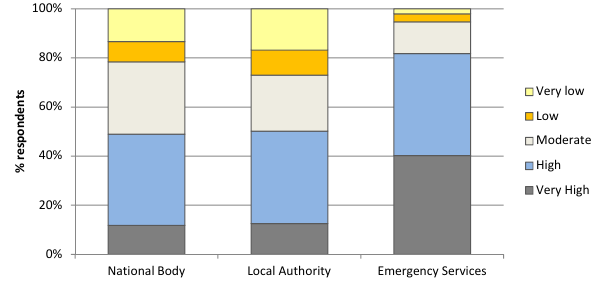
Fig. 9. Assessment of how public queries to national bodies ( n = 73), local authorities ( n = 193) and emergency services ( n = 161) were received in Ireland and